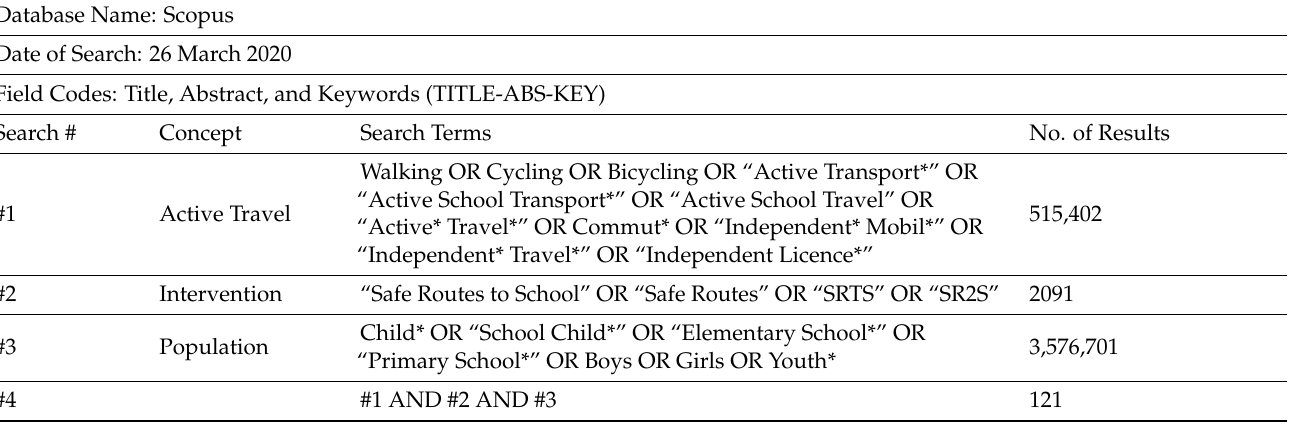
Table 1. Example Search Strategy for Database Search